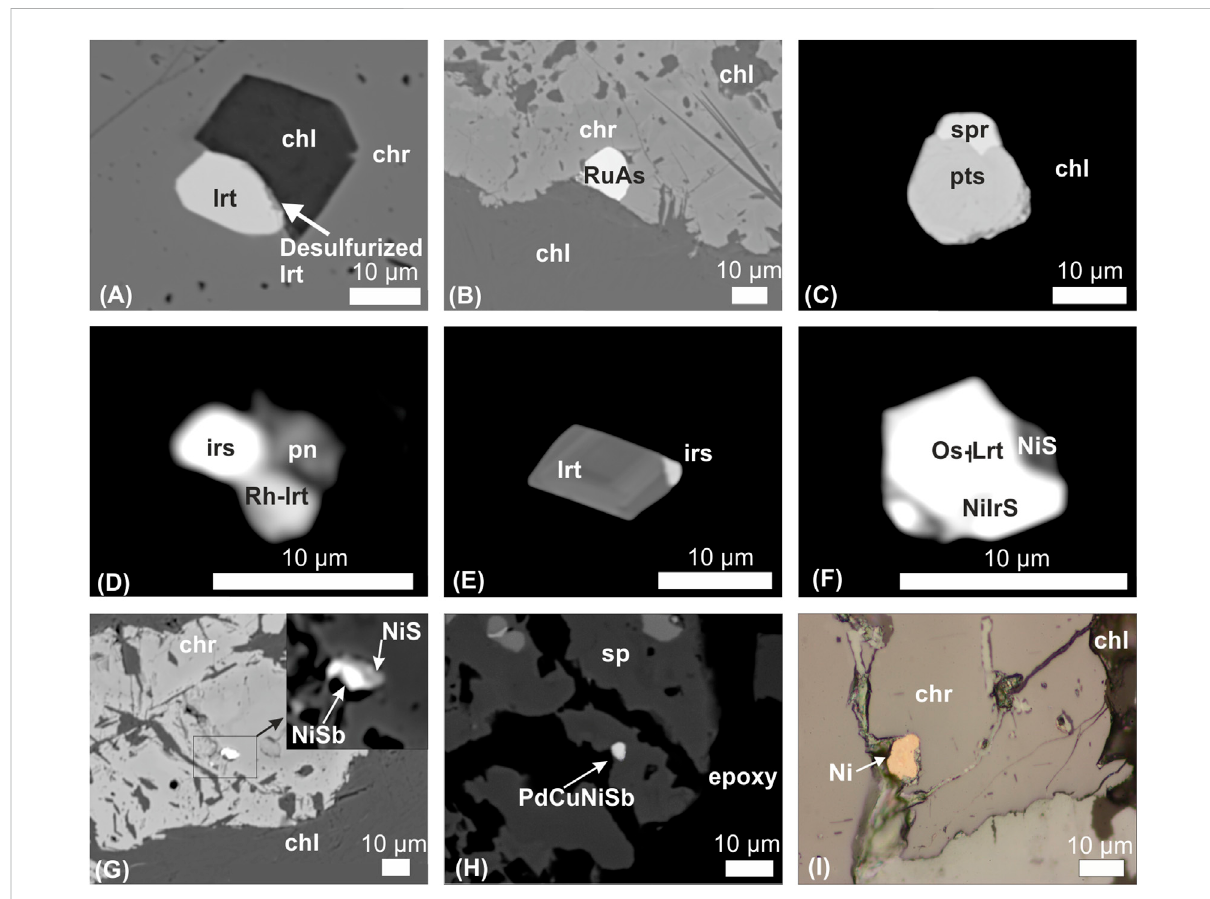
FIGURE 8 B.S.I. of PGM and related phases, the white bar is 10 μ m in length: (A) subhedral G2 laurite grain in contact with chlorite and desulfurized laurite as inclusions within spinel. (B) G2 subrounded ruarsite engulfed within the spinel rim, primary minerals have been altered into chlorite. (C) NR subrounded platarsite in contact with anhedral sperrylite within the chlorite interstices. (D) NR PGM assemblage composed of subhedral Rh-rich laurite, irarsite and anhedral pentlandite in contact with chlorite (E) NR oscillatory laurite in contact with irarsite and chlorite. (F) NR Os-rich subhedral laurite in contact with Ni- “ iridsite ” and Ni-sul fi de. (G) G2 Ni-antimonide and Ni-sul fi de within altered spinel with chlorite intergrowths. (H) G1 PGM PdCuNiSb enclosed in liberated spinel grain from chromitite concentrates. (I) Photomicrograph of NR Ni enriched in P along the contact